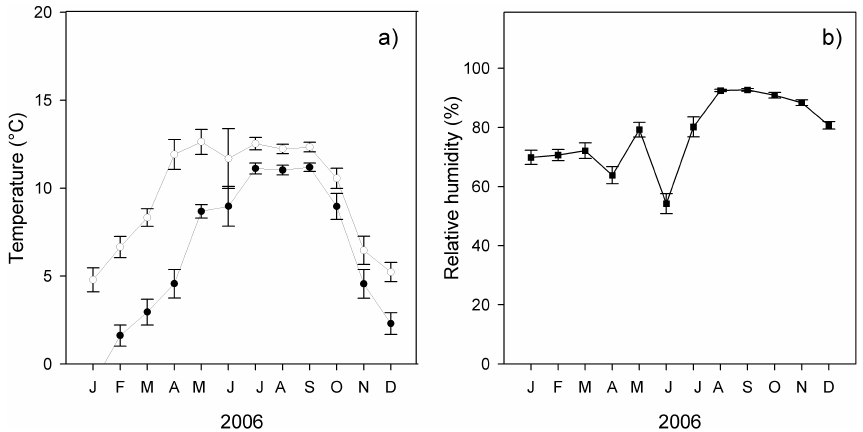
Fig. 5. Mean and standar error of (a) air temperature ( ◦ ), dew point temperature ( • ) and (b) relative humidity (RH) for morning hours 04:00 to 08:00a.m. at the study